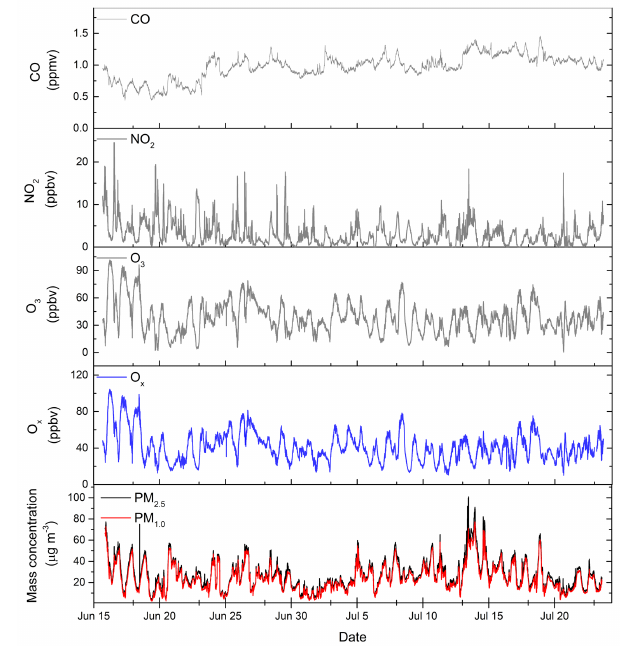
Figure 1. Time series of CO, NO 2 , O 3 , and O x (O 3 + NO 2 ) concen- trations, as well as the concentrations of PM 2 . 5 and PM 1 . 0 during the measurement